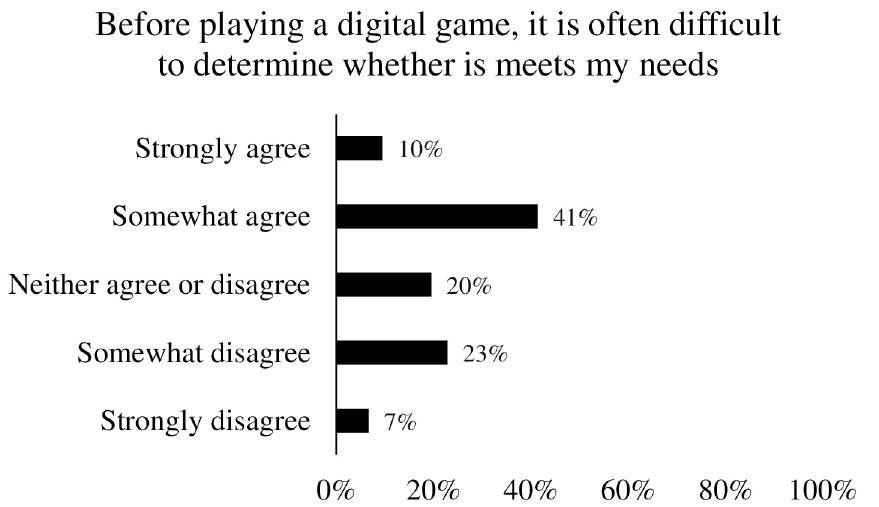
Fig 4. Response distribution for difficulty determining game suitability.